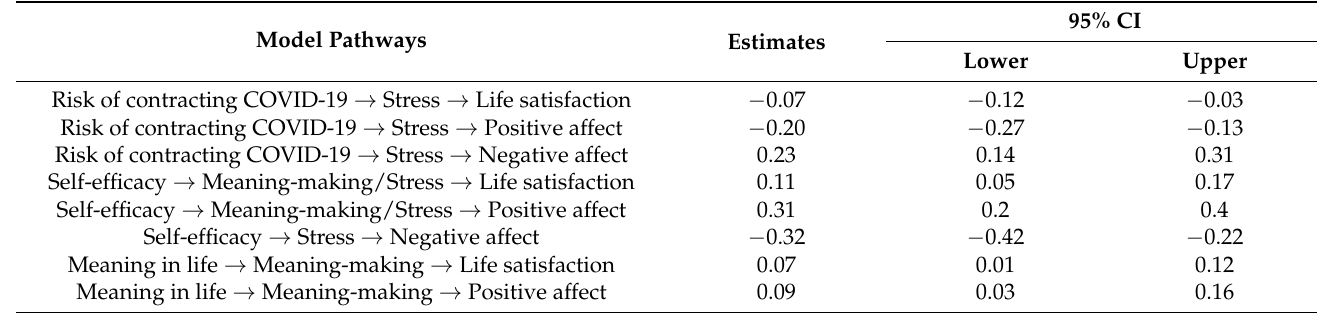
Table 2. Bootstrapping-standardized indirect effects and 95% confidence